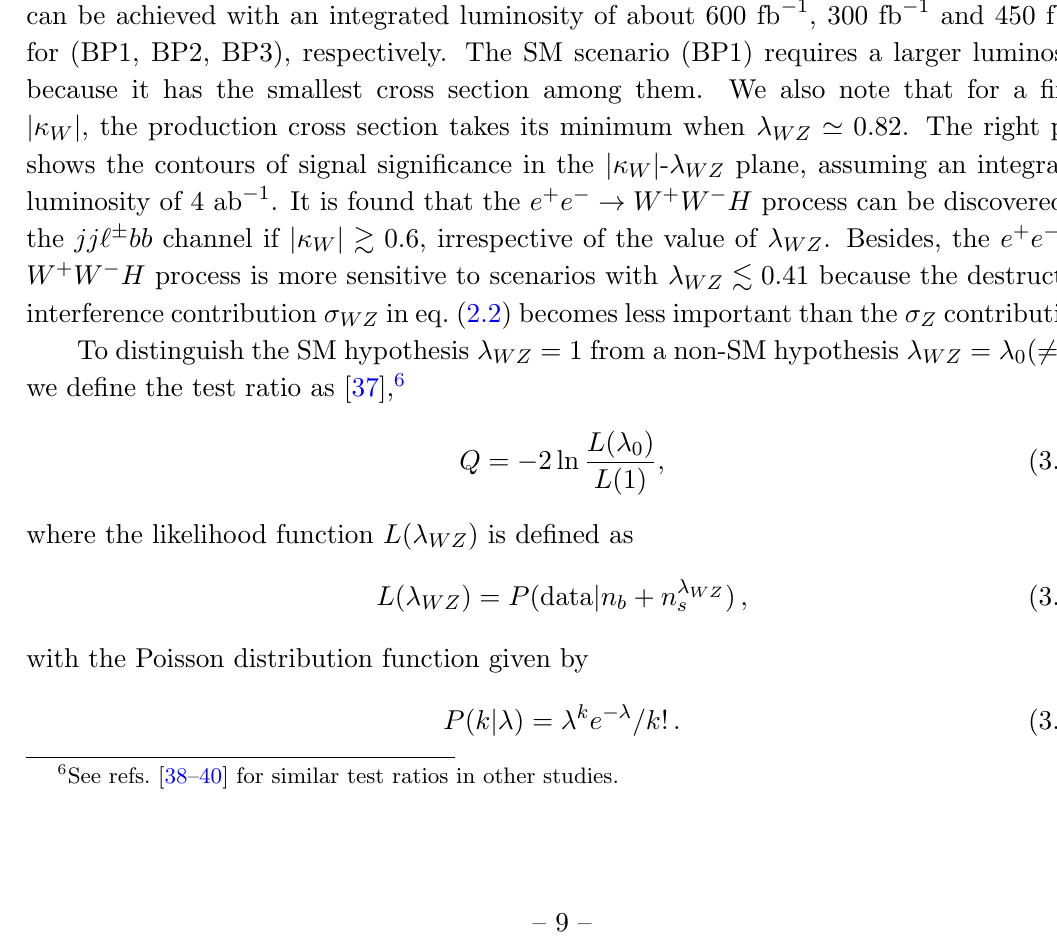
The left plot considers the three scenarios (BP1, BP2, BP3). It is seen that a 5 (cid:27) discovery can be achieved with an integrated luminosity of about 600 fb (cid:0) 1 , 300 fb (cid:0) 1 and 450 fb (cid:0) 1 for (BP1, BP2, BP3), respectively. The SM scenario (BP1) requires a larger